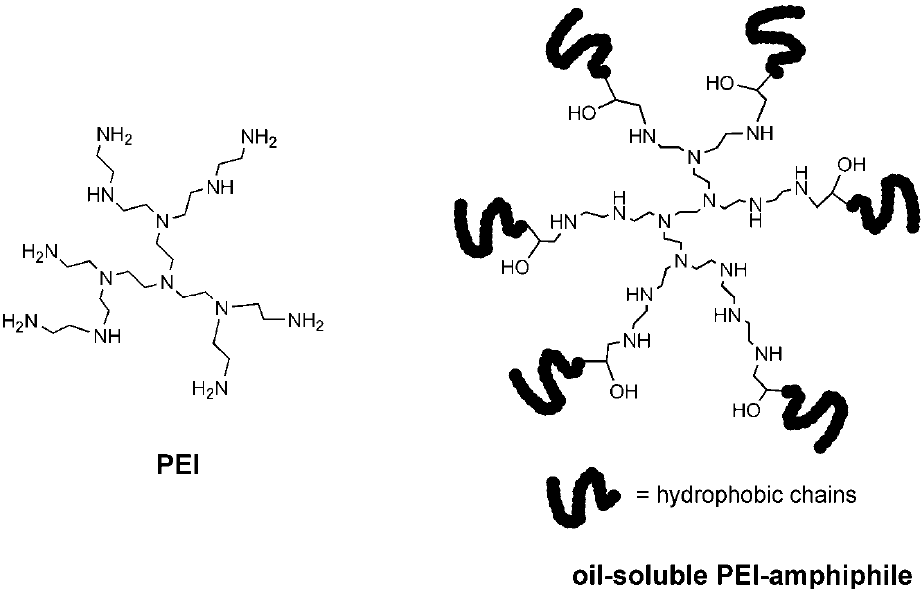
Figure 1. Chemical structures of polyethyleneimine (PEI) and typical oil-soluble PEI macrosurfactant. PEI contains thousands of repeat units, but only some are shown here for clarity.